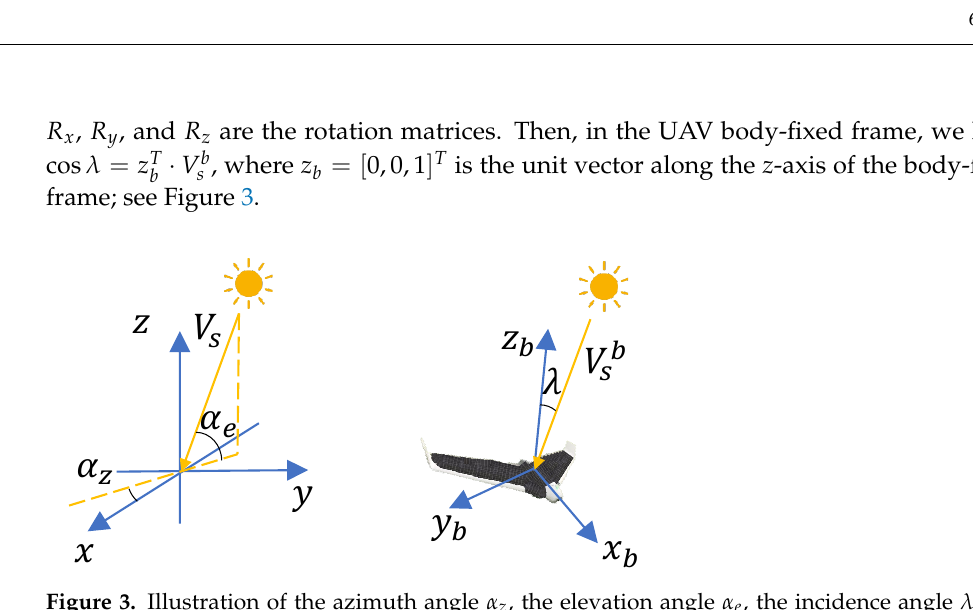
Figure 3. Illustration of the azimuth angle α z , the elevation angle α e , the incidence angle λ , and vectors V s and V b s